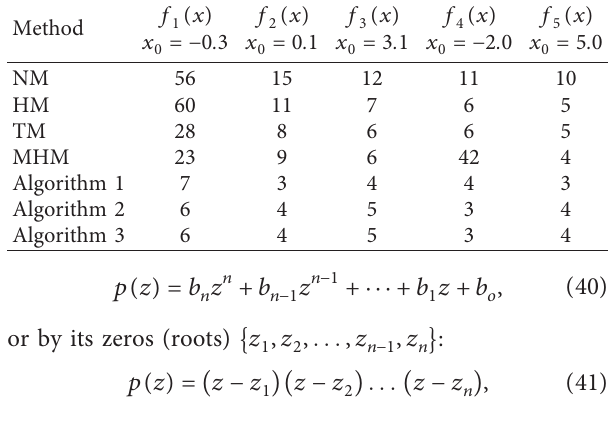
Table 2: Comparison of number of iterations required for different iterative methods for ε � 10 –100